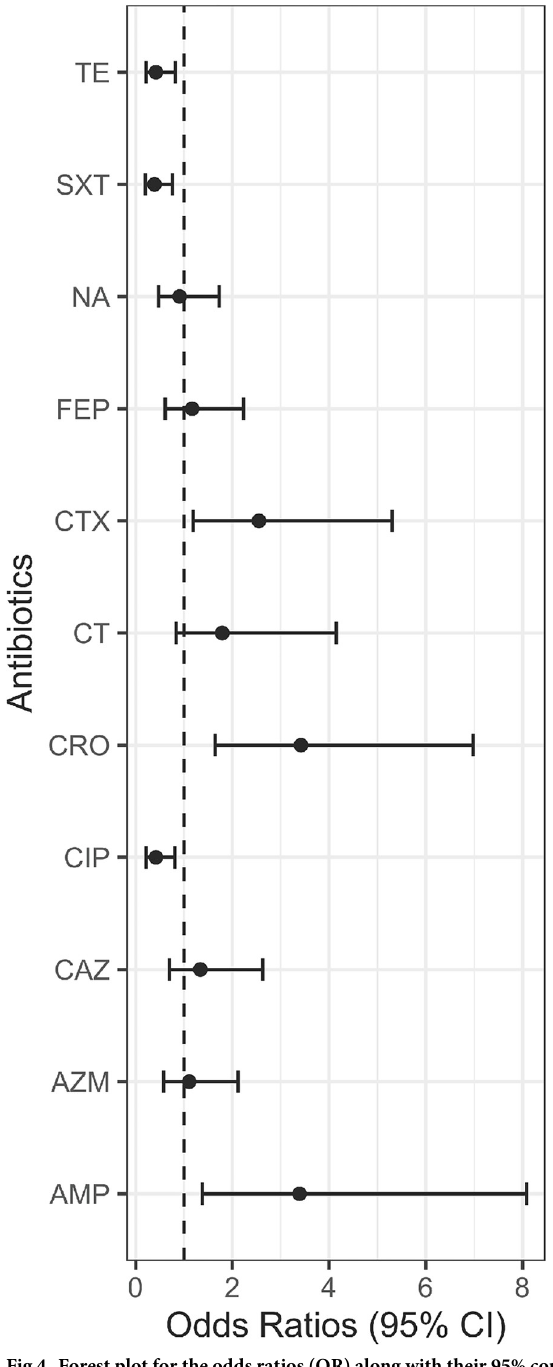
Fig 4. Forest plot for the odds ratios (OR) along with their 95% confidence intervals (CIs). The black dot indicates the OR of being resistant to the corresponding antibiotics in the arsenic-resistant group of isolates compared to the arsenic-sensitive group of isolates. The whiskers are the spread of the CIs of the OR. The dotted line indicates the OR of 1 which implies no association. AMP, ampicillin; TE, tetracycline; CRO, ceftriaxone, CTX, cefotaxime; CAZ, ceftazidime; FEP, cefepime; CT, colistin; CIP, ciprofloxacin; NA, nalidixic acid; AZM, azithromycin; SXT, trimethoprim-sulfamethoxazole.